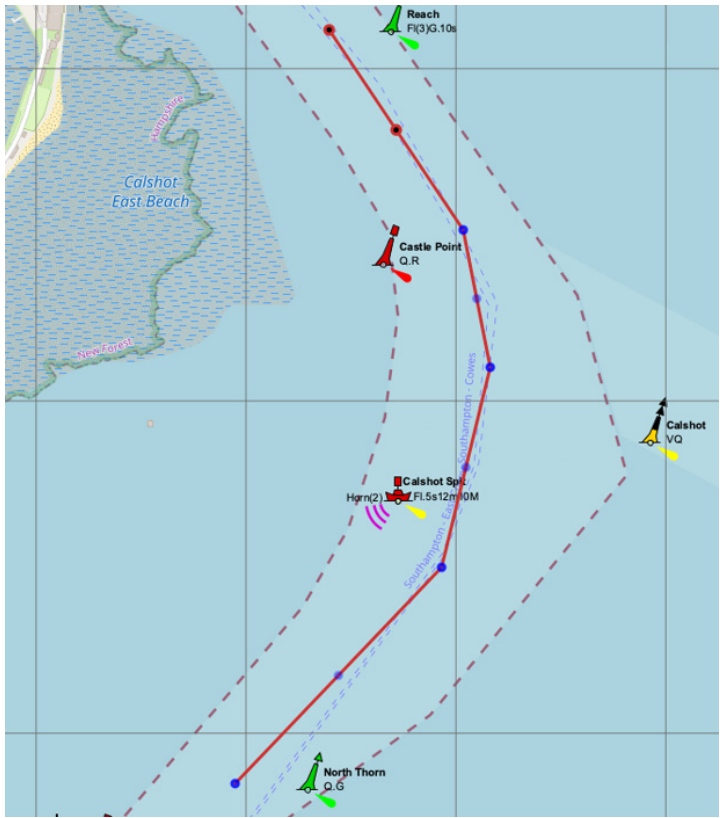
Figure 4. Approach channel bend near Southampton port, where: QG, VQ, QR, “Cals hot”, etc. – names of buoys; Horn(2)Fl.5s12m10M – characteristics and visibility distance of the lighthouse [21].